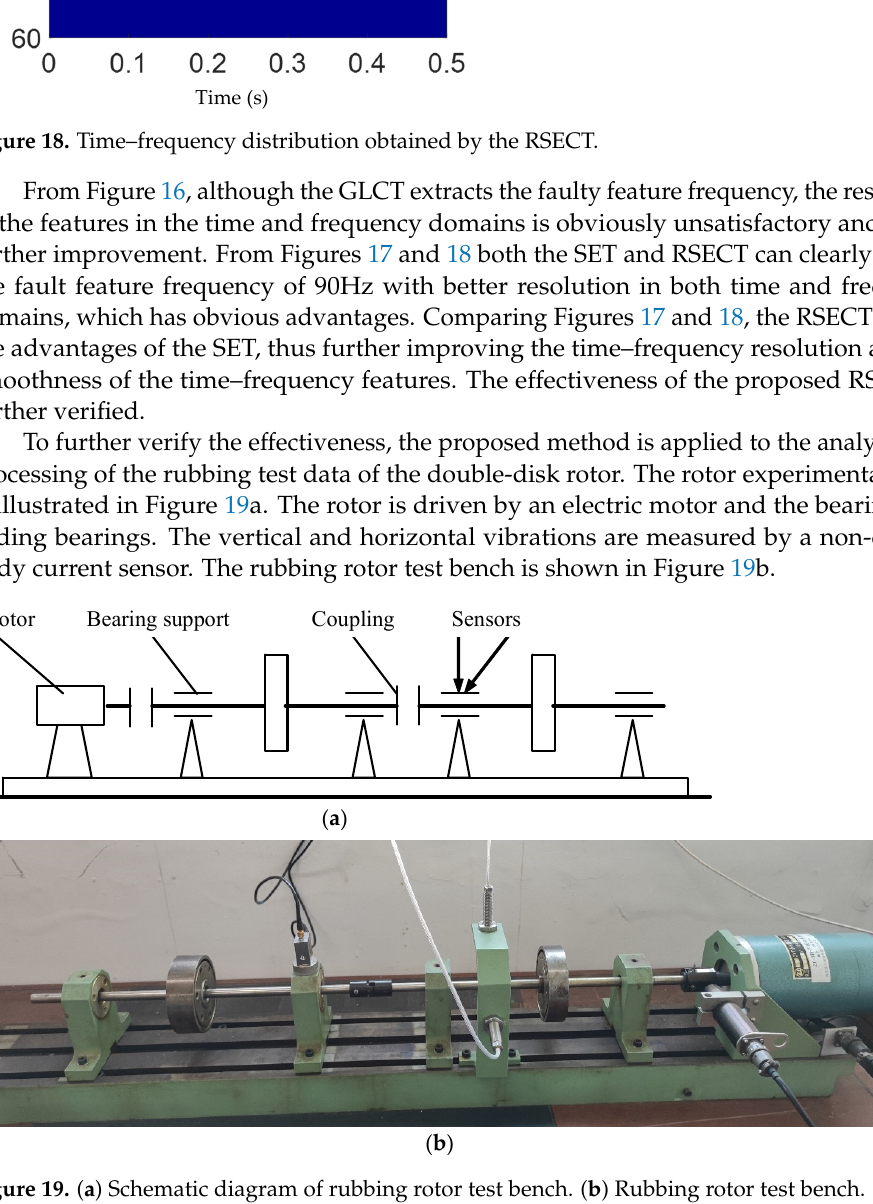
Figure 18. Time–frequency distribution obtained by the RSECT. Figure 18. Time – frequency distribution obtained by the RSECT. Figure 18. Time – frequency distribution obtained by the RSECT.